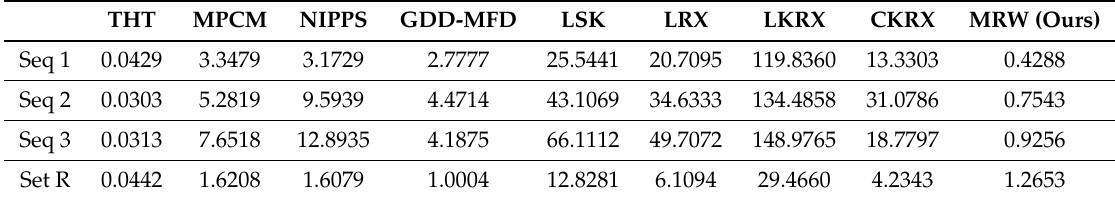
Table 4. Average running time (s) of different methods testing on the